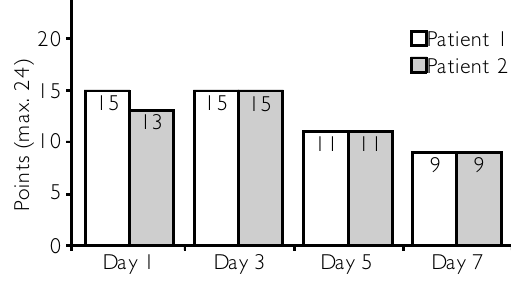
Course of Multiple Organ Dysfunction